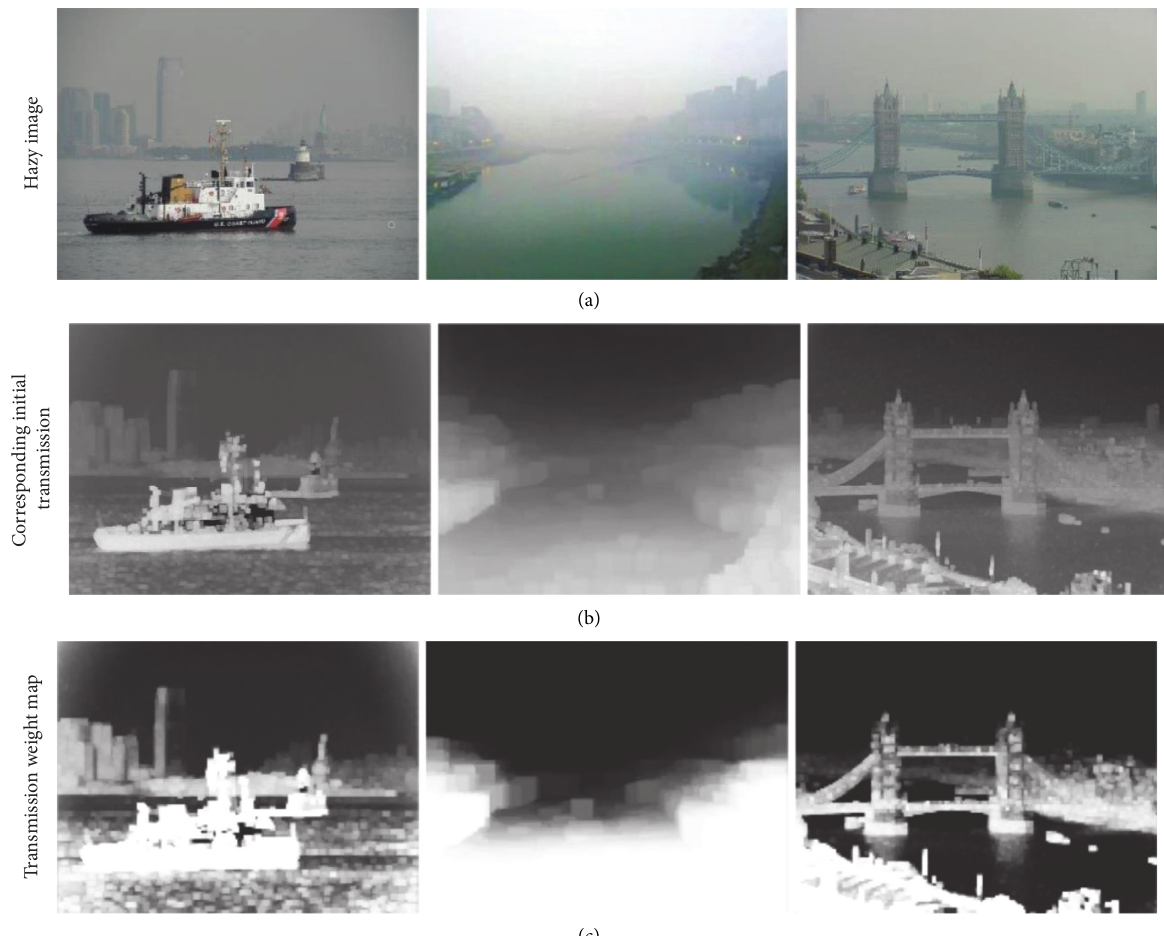
Figure 2: The result of the sky region segmentation. (a)-(c) From top to bottom: the hazy image on the water with a large sky region, the corresponding initial transmission, and the transmission weight